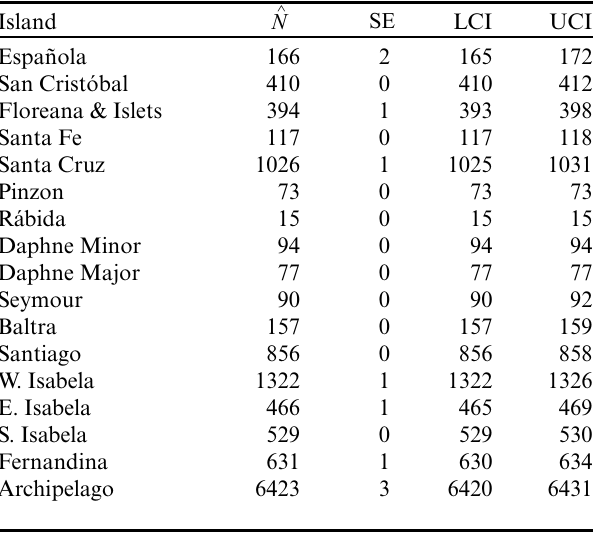
Table 4 . Population size estimates ( ) by island, standard errors (SE) and lower (LCI) and upper (UCI) 95% confidence intervals for Blue-footed boobies ( Sula nebouxii excisa )